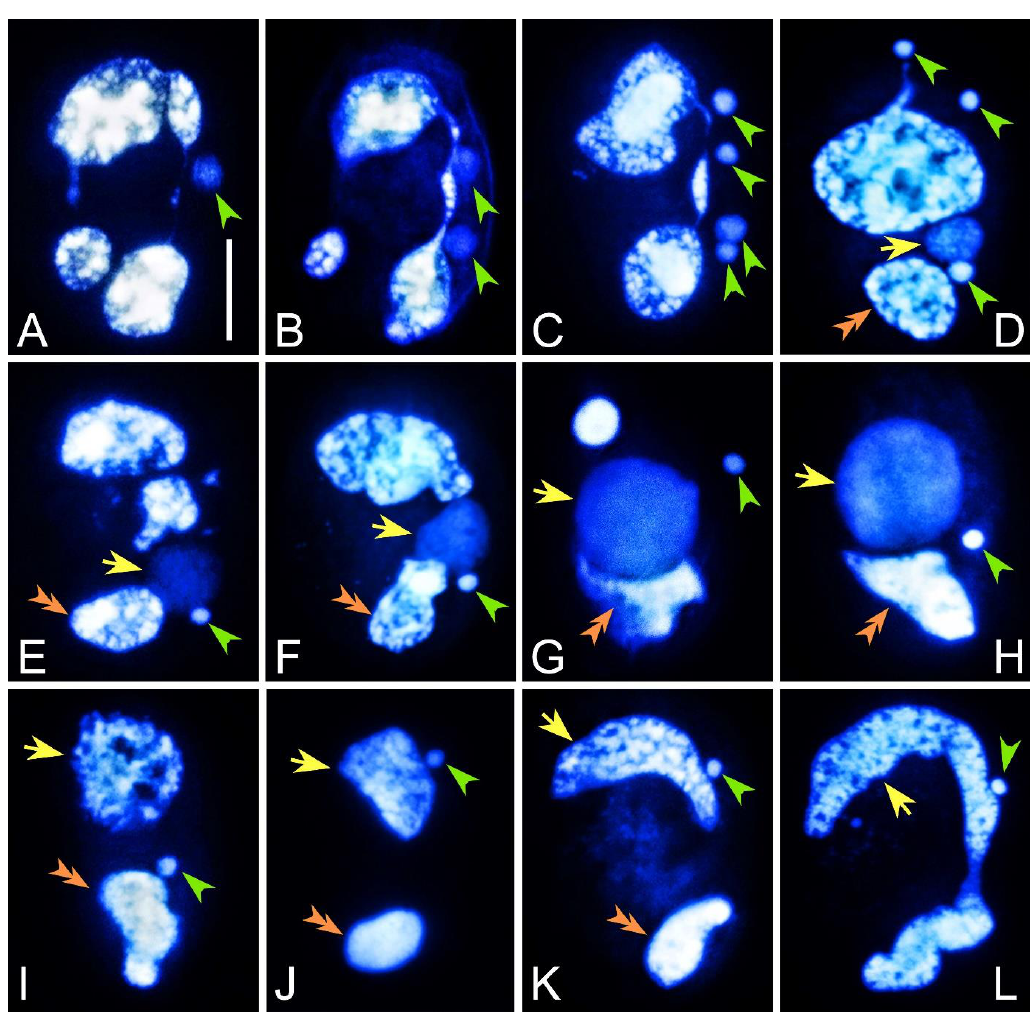
Figure 2. Nuclear events in the exconjugants of Euplotes raikovi after Hoechst 33342 staining. ( A ) After mating pair separation, the parental MAC breaks into fragments. ( B – C ) First and second postzygotic divisions of the synkaryon. ( D – H ) One out of the four products (usually the third one from anterior to posterior) of the synkaryon divisions swells and differentiates into the MAC anlage.